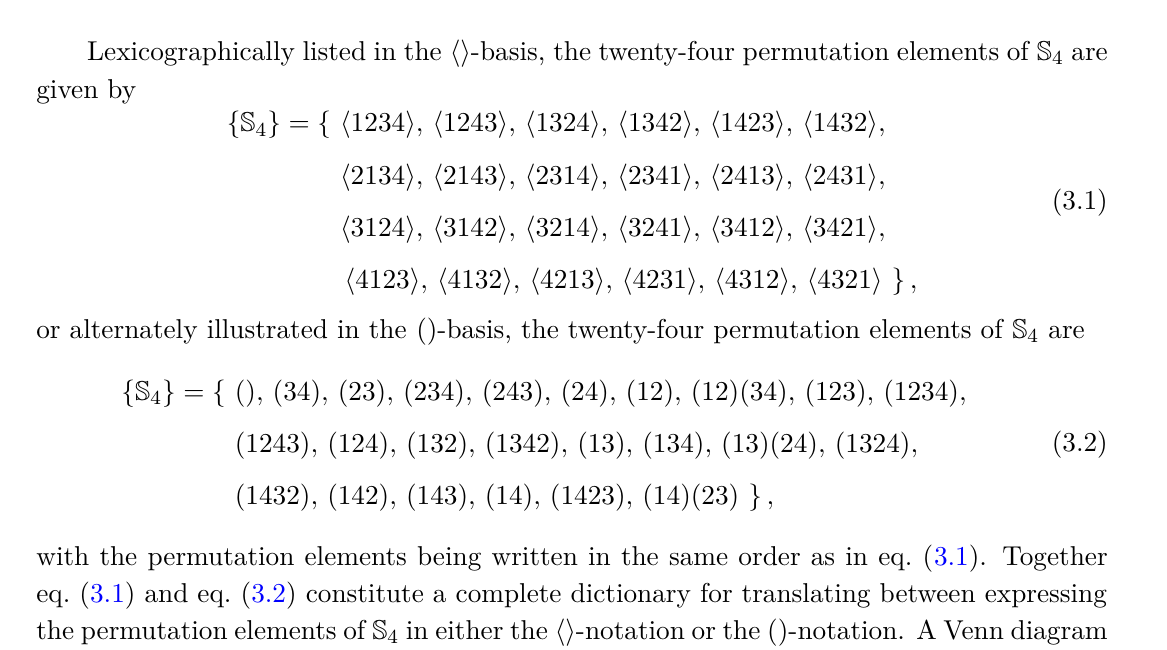
Figure 1 . A Venn diagram representation of BC 4